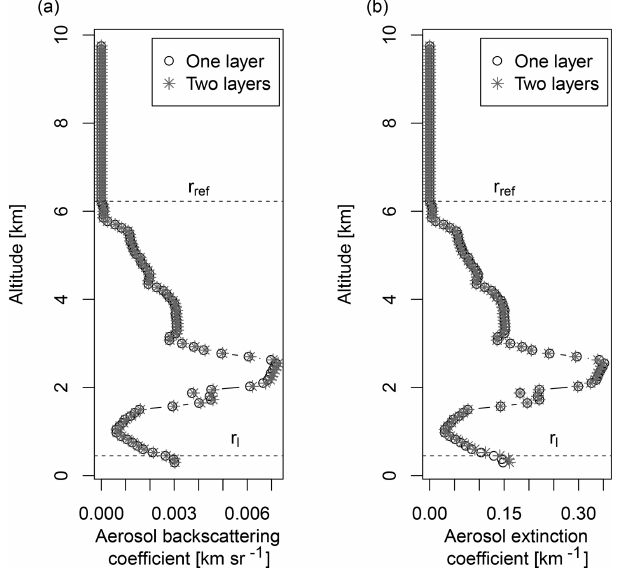
Figure 14. Example of the extinction and backscattering coef- ficients under heavy aerosol load conditions obtained by using one- and two-layer methods applied to a lidar profile made on 28 June 2012. Upper limits of the MBL ( r l ) and FT ( r ref ) are repre- sented by horizontal dashed